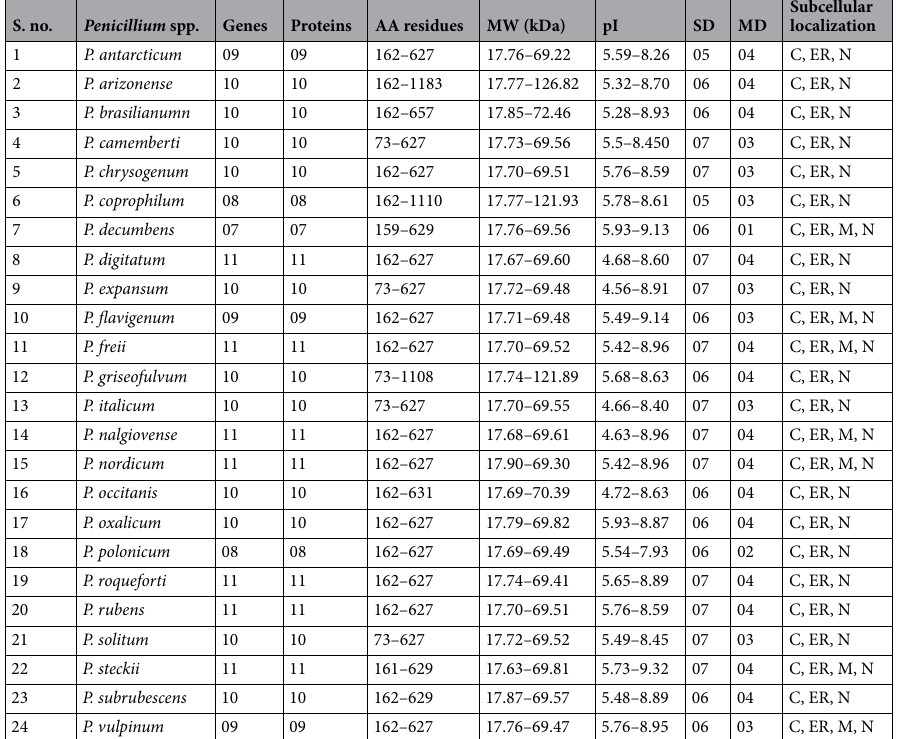
Table 1. Genome-wide analysis of cyclophilin proteins in different Penicillium spp . AA: amino acids; C: cytoplasm; ER: endoplasmic reticulum; kDa: kilodalton; M: mitochondria; MD: multi-domain; MW: molecular weight; N: nucleus; pI: isoelectric point; SD: single